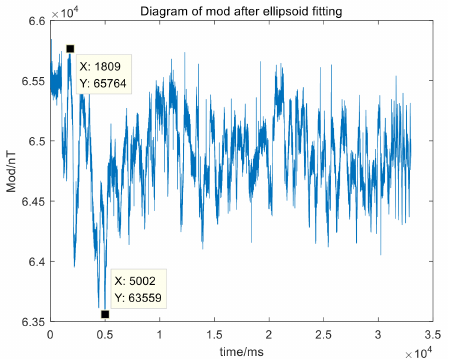
Figure 11. Diagram of modules after